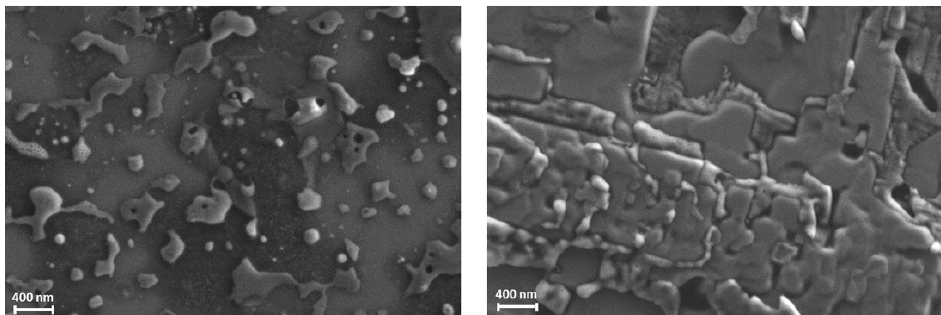
Figure 8. The SEM micrographs of liposomes ( left ) and biohybrids BSA NPs—liposomes ( right ) at the magnification of 20,000×. The samples were deposited on Si substrates.